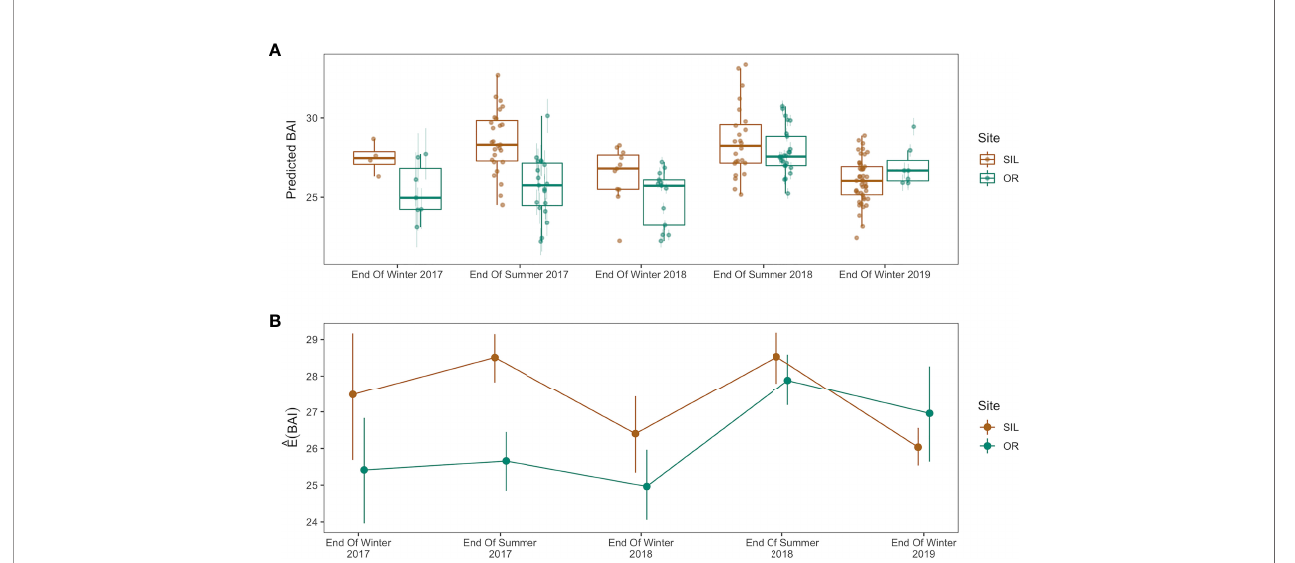
FIGURE 6 | Change in gray whale body condition in San Ignacio Lagoon (SIL), Mexico and Oregon, USA by phenology group and year: End of wintering season (arrival Oregon vs. departure SIL) and End of summer feeding season (departure Oregon vs. arrival SIL). (A) Boxplots illustrating the distribution of gray whale estimated Body Area Index (BAI) values across years and phenology group as produced by the Bayesian statistical model accounting for measurement uncertainty. The group median (horizontal line), 75% distribution (box), 95% range (vertical lines), and outliers (dots) are depicted. The overlaid points represent the mean of the posterior predictive distribution for BAI for an individual and the bars represent the upper and lower bounds of the 95% HPD interval. (B) Estimated mean BAI values for SIL and Oregon across phenology groups and years derived from the nested ANOVA test of H 2 . Points represent the mean BAI estimate and vertical lines represent simultaneous Monte Carlo con fi dence